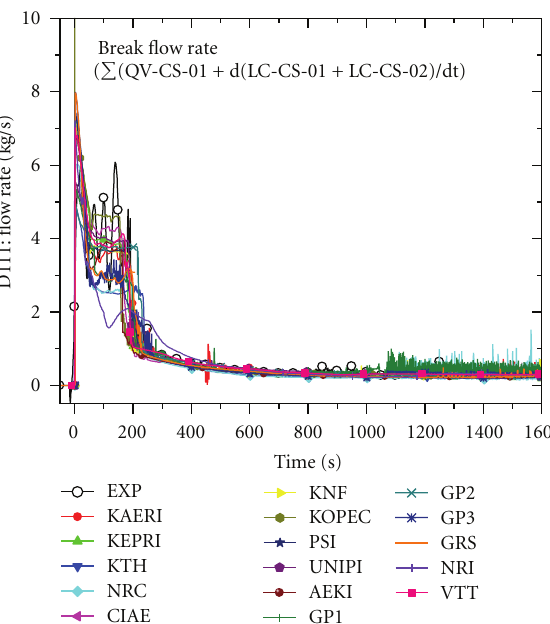
Figure 12: Comparison of the calculated break flow rates with the measurement